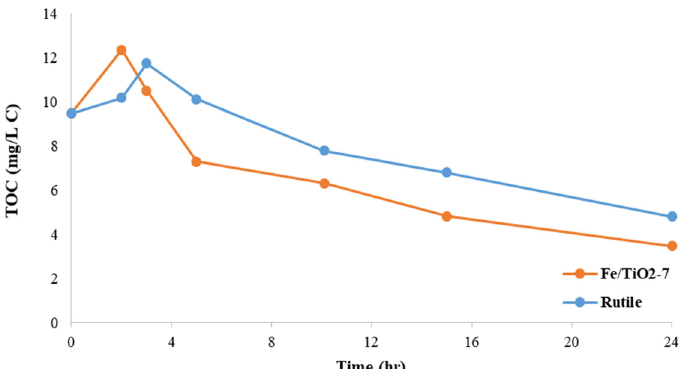
Figure 13. Plots of TOC removal during photocatalytic oxidation reactions over TiO 2 and Fe/TiO 2 -7 under visible light irradiation. Note: [2,4-DCP] 0 = 4.08 mg/L, [TOC] 0 = 9.47 mg/L, catalyst loading = 1 g/L, room temperature, no pH adjustment.